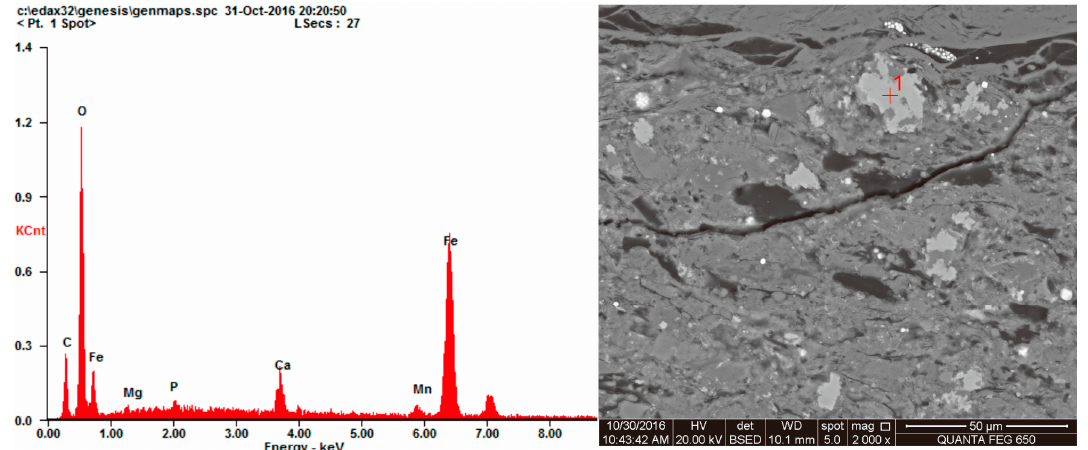
Figure 8. SEM backscattered electron image of minerals and EDS spectrum of spot 1 (SGT1-11).